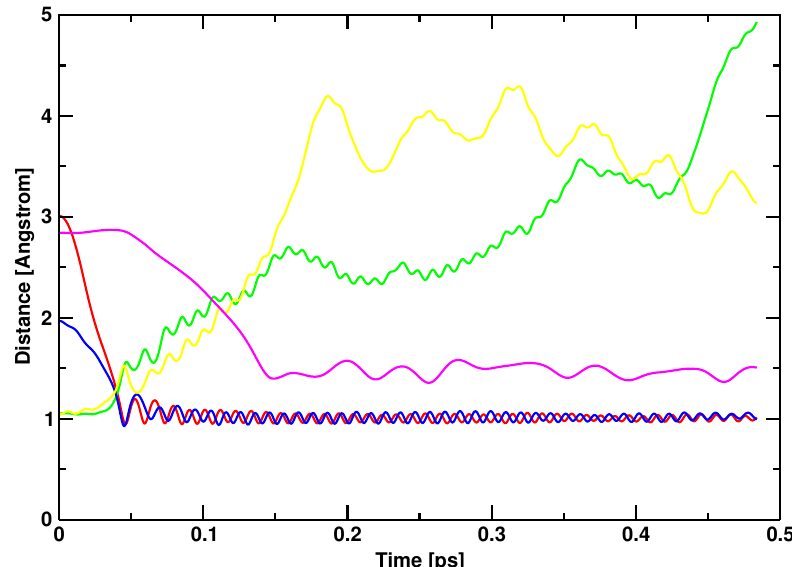
Figure 7. Formation of 2f : Change of distances with time, compare to Figure 6. Green and yellow: bonds that are broken. Red, blue and magenta: bonds that are formed.